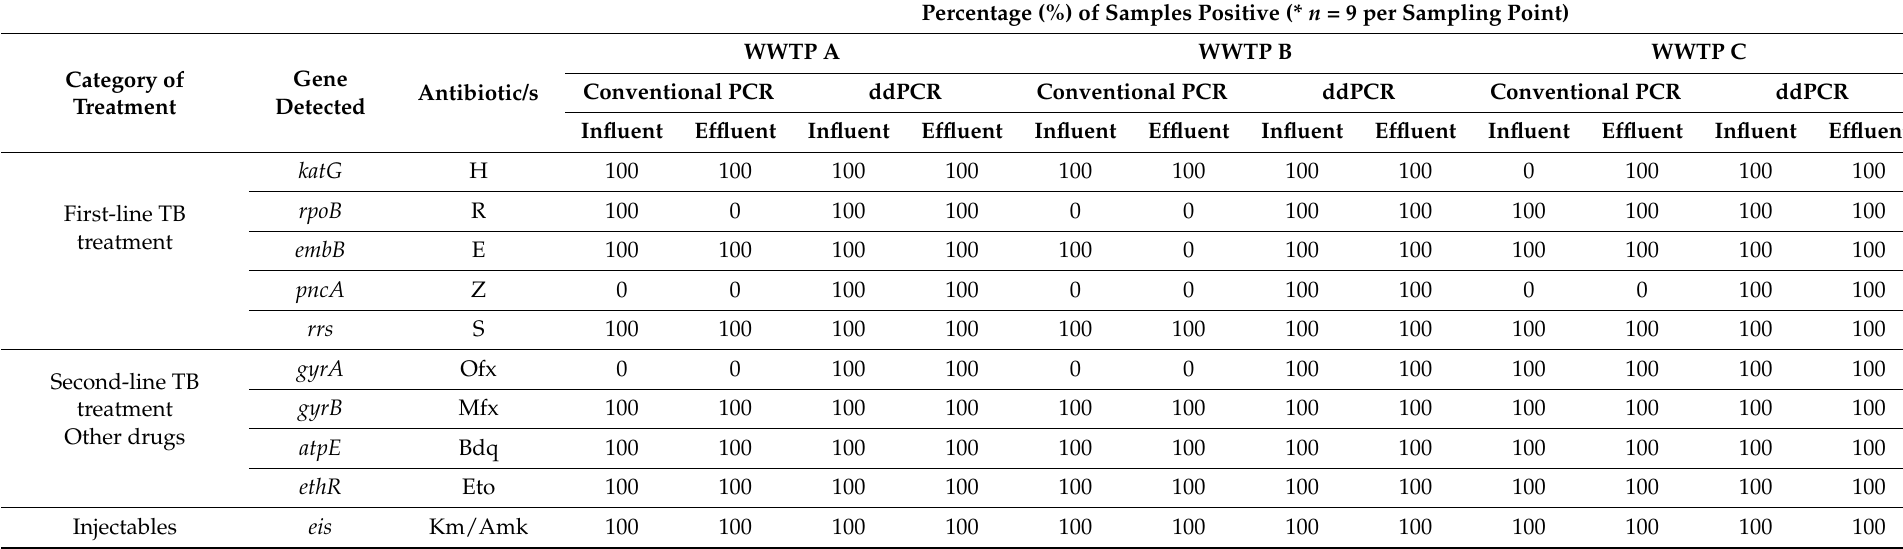
Table 3. Detection of antimicrobial resistance genes associated with drug-resistant